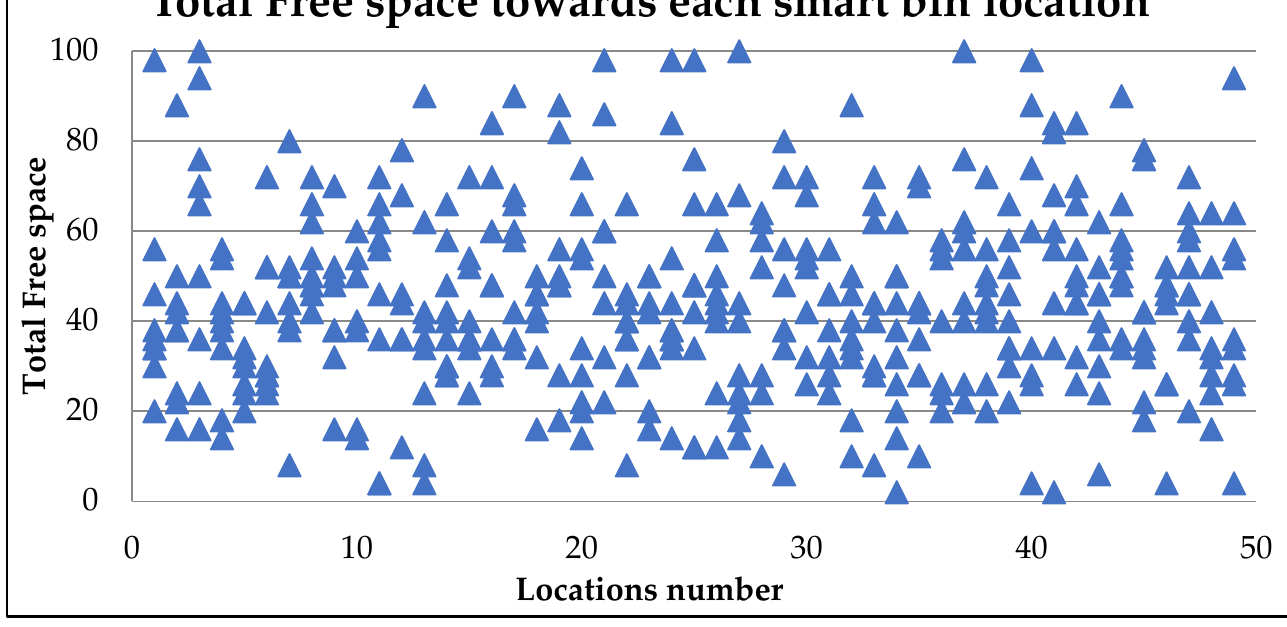
Figure 18. Total free space towards each smart bin location-Type 1.